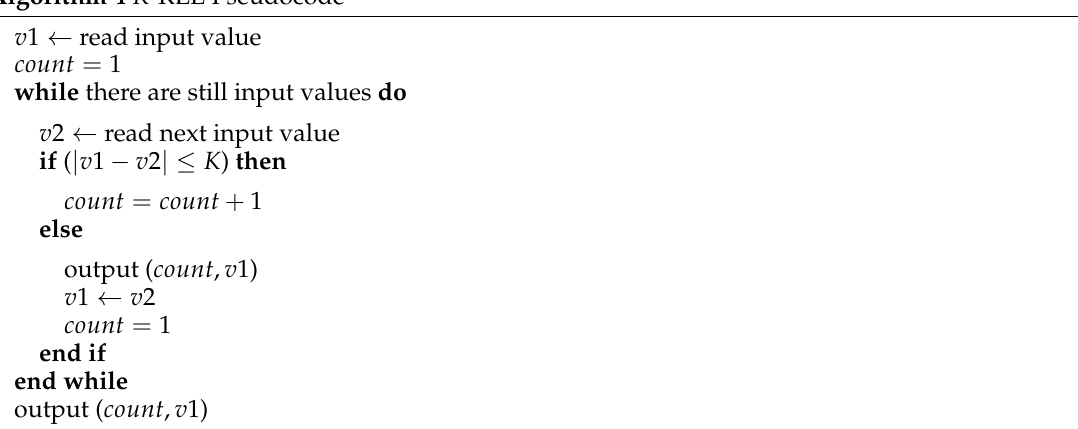
Algorithm 4 K -RLE Pseudocode